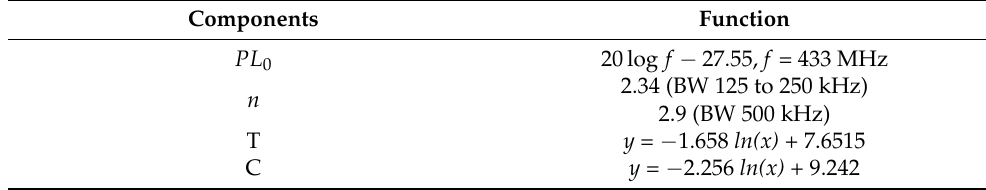
Table 6. PL prediction model for 433 MHz.